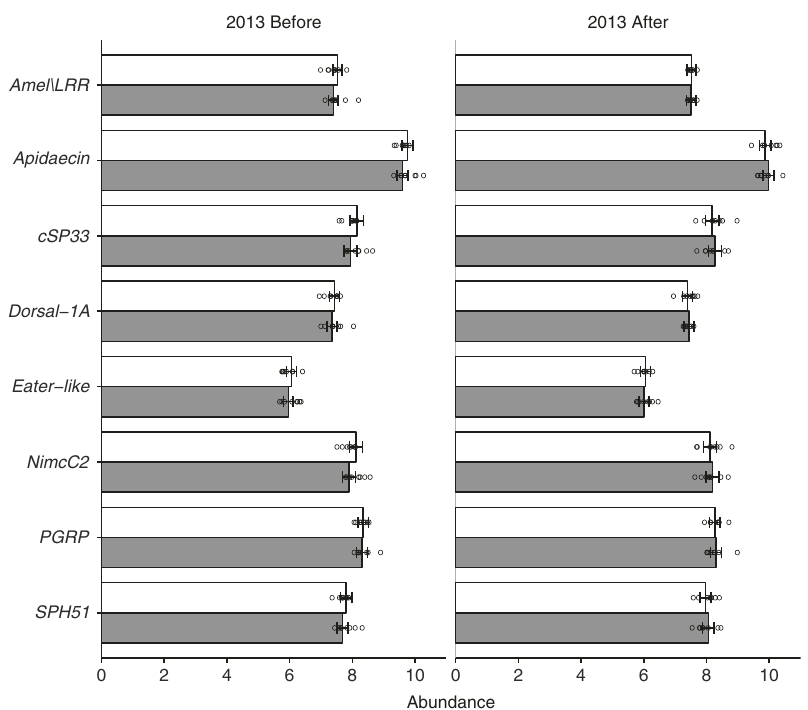
Fig. 6 Immune gene expression at apiary level in 2013. The abundance (±95% con fi dence intervals) of expressed immune genes in honeybees at apiary level in 2013 in relation to the treatment (control = white bars; clothianidin-treated = grey bars) in oilseed rape fi elds ( n = 8 fi elds per treatments) before and after their bloom. Immune gene expression data are presented as the log 10 number of estimated mRNA copies per bee. Circles indicate measured values per